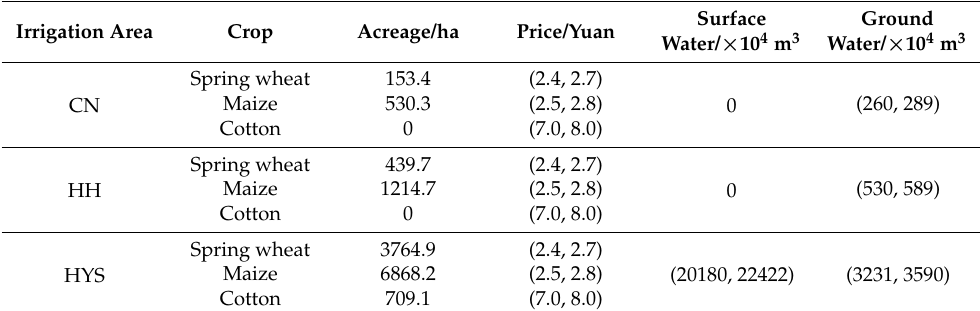
Table 2. Basic data of three irrigation districts and